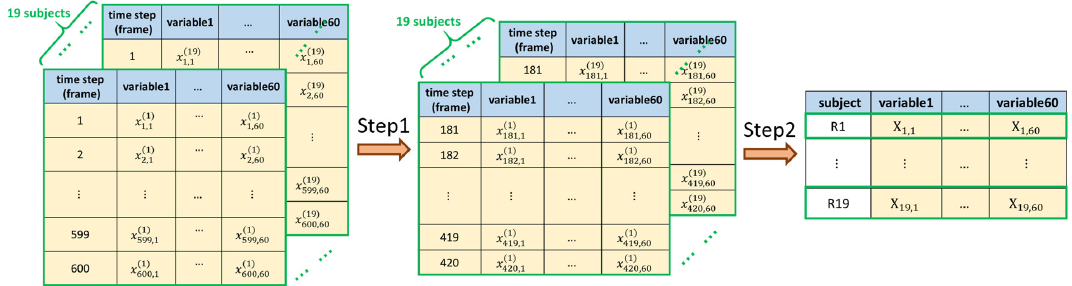
Figure 3. Diagram of the proposed data pre-processing.